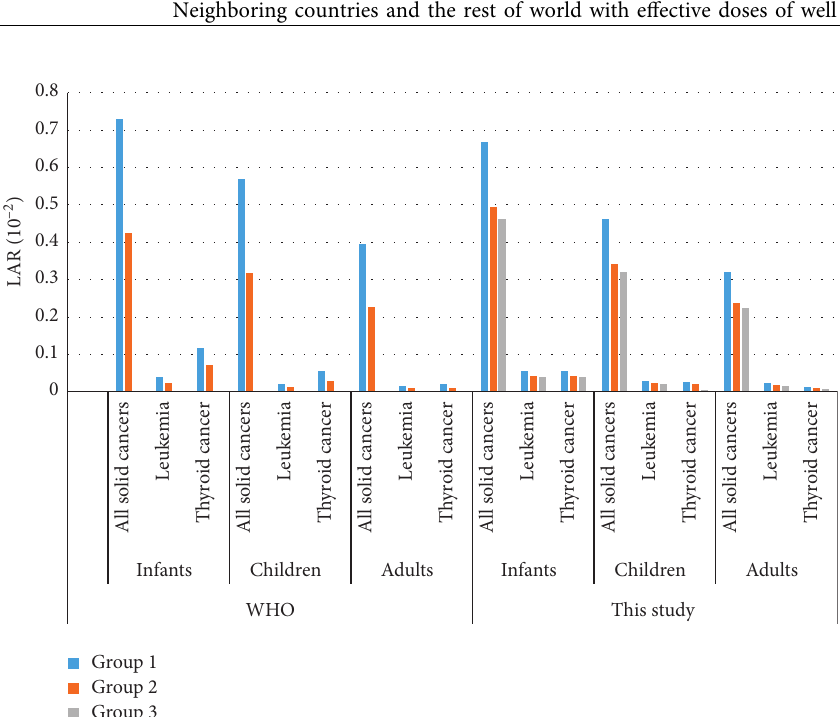
Figure 1: Comparison of LAR for cancer sites of males between WHO and this